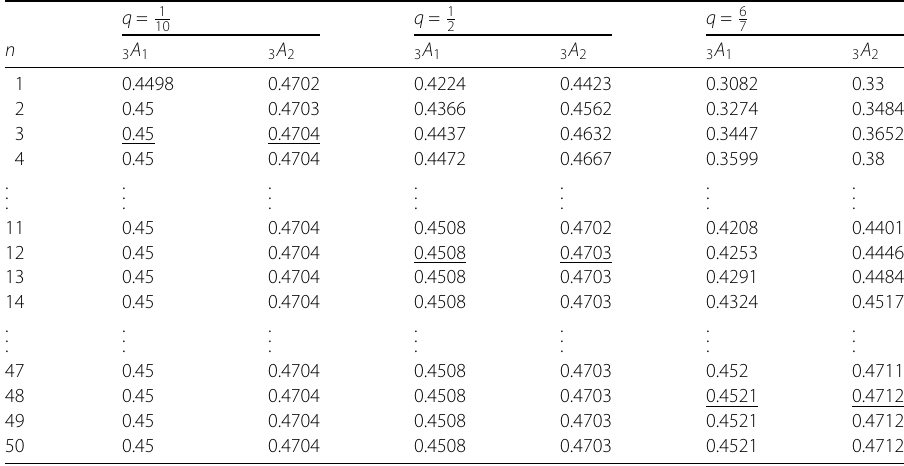
Table 4 Some numerical results for 4 A 1 and 4 A 2 in Example 1 for q = 1